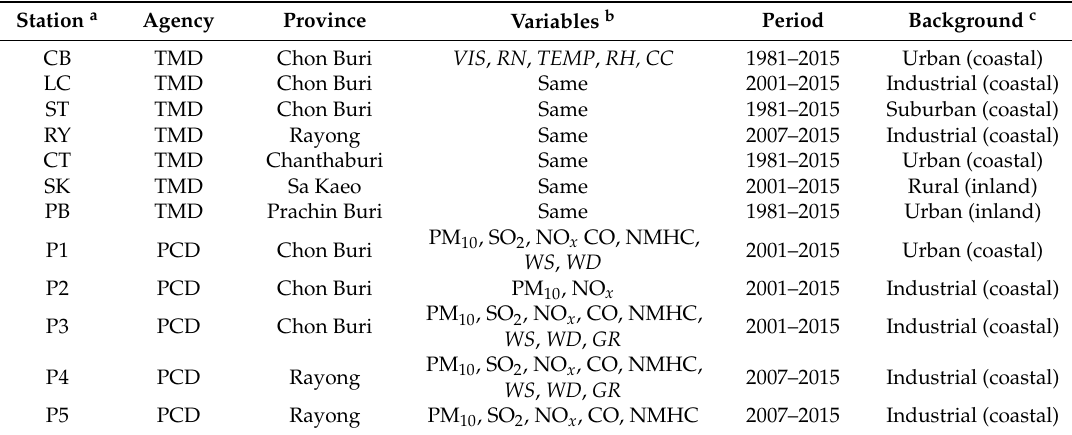
Table 1. Monitoring stations and associated